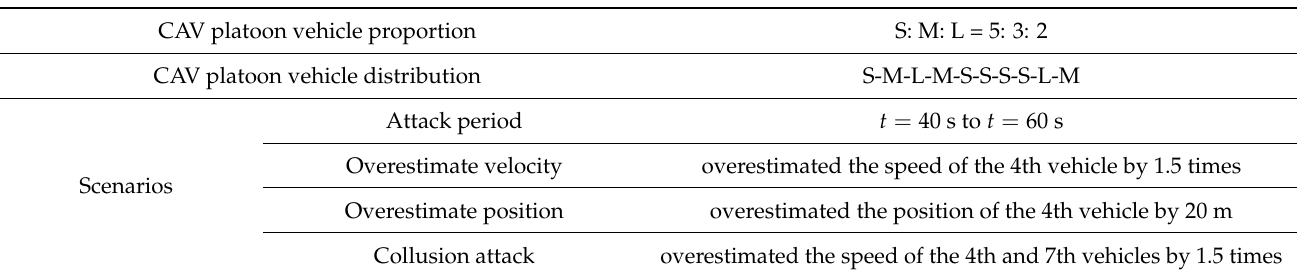
Table A3. Simulation conditions.